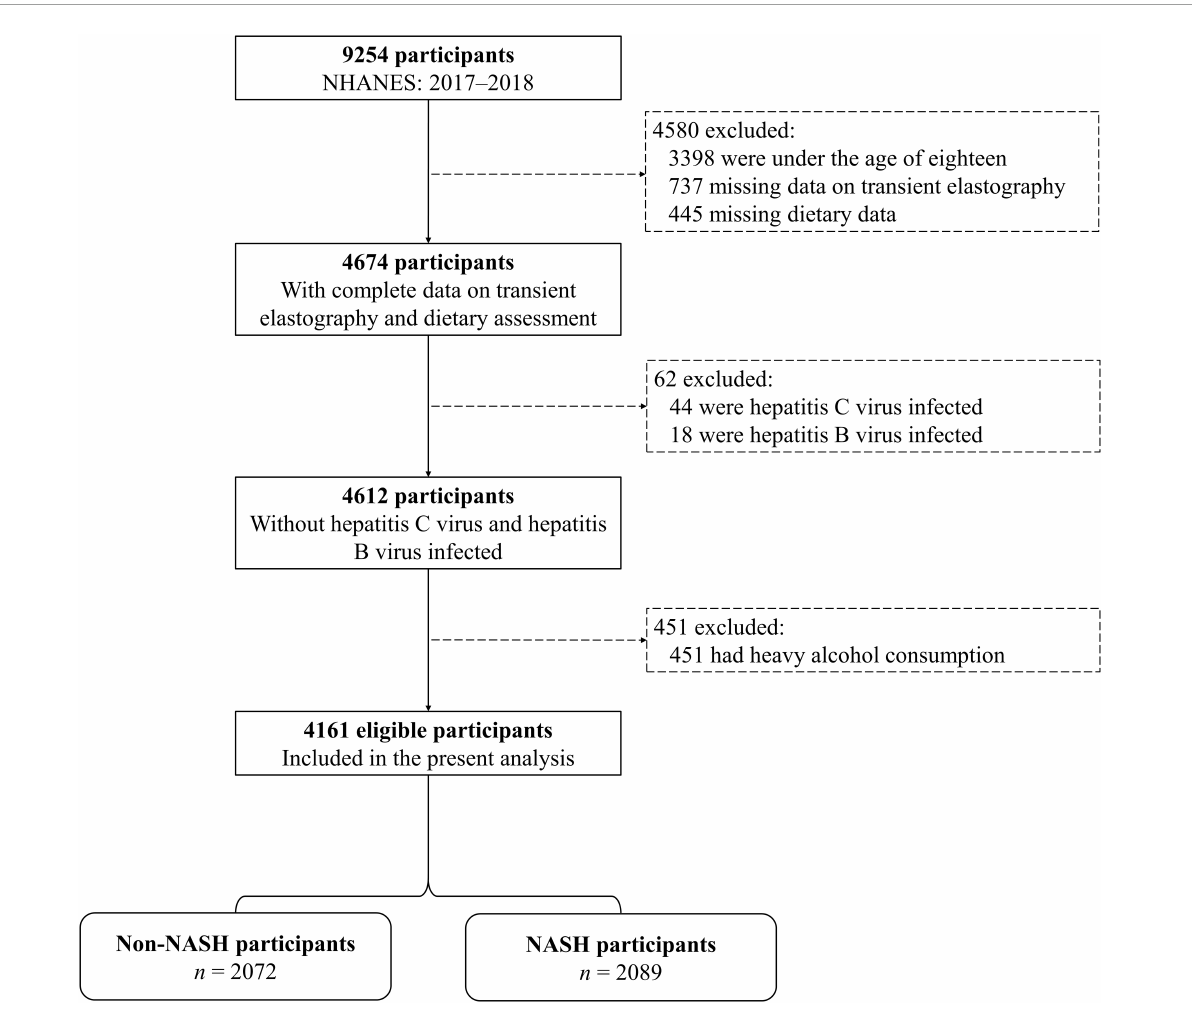
FIGURE1 Flowchart of selection of participants from national health and nutrition examination survey (NHANES). Abbreviations: NASH, non-alcoholic